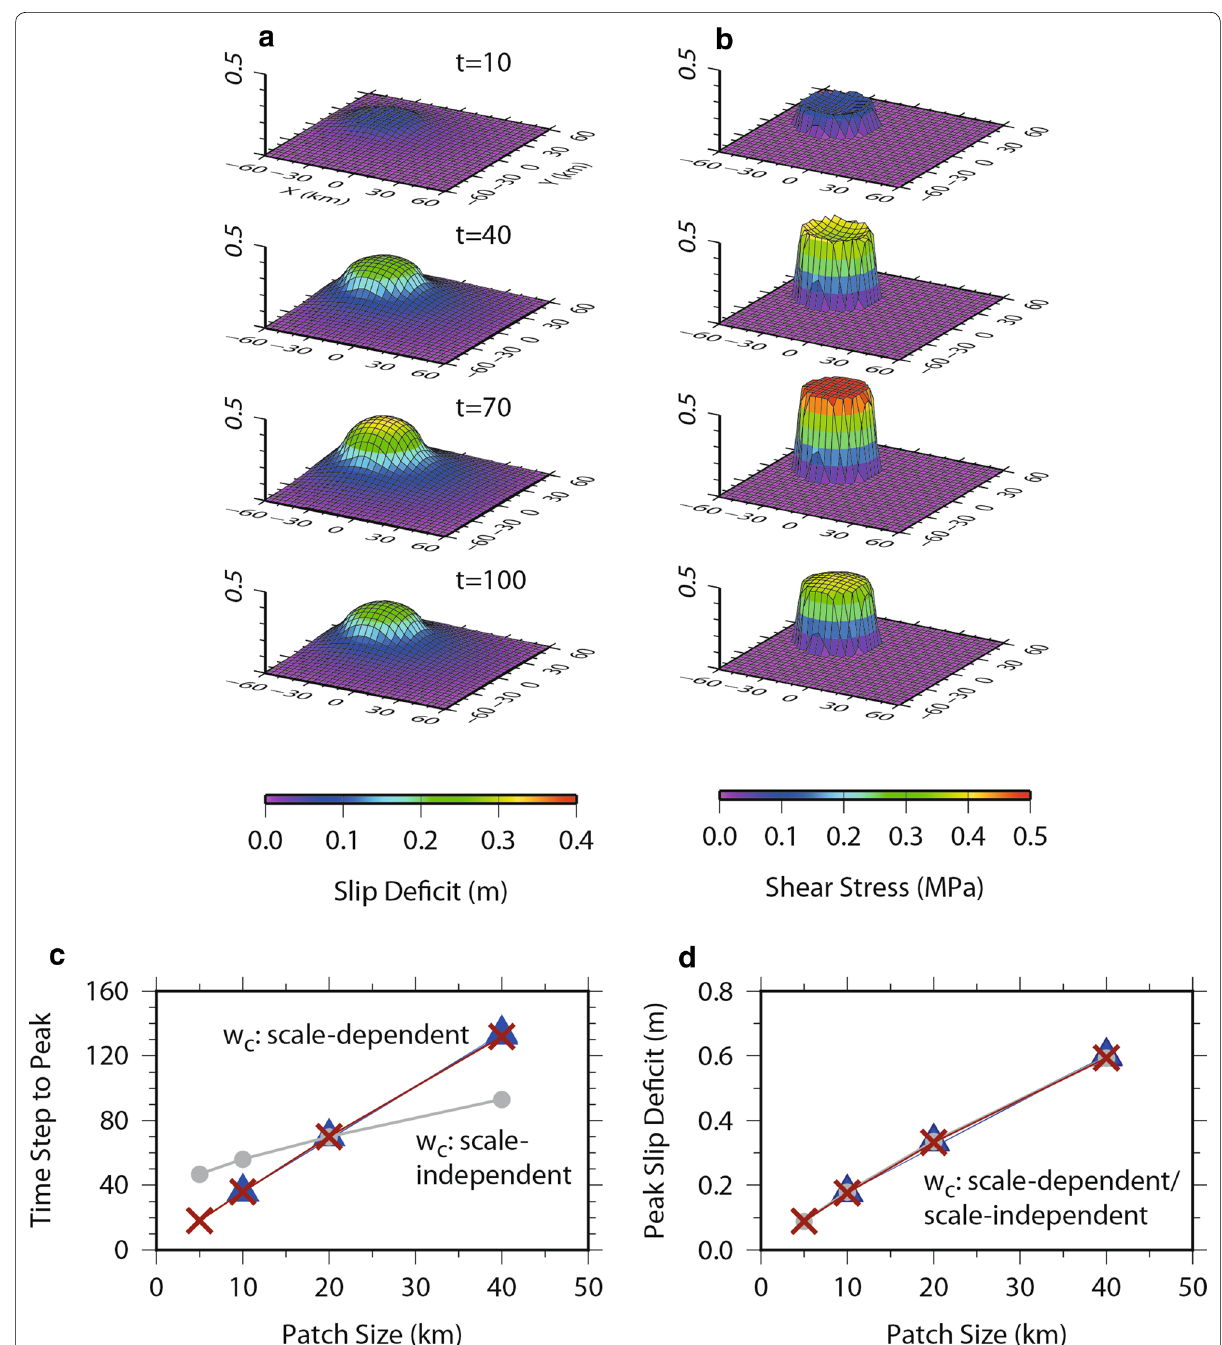
Fig. 2 Snapshot of the quasi-static evolution of fault slip for a single patch of R = 20 km , w c = 0.4m , w 0 = 0m , and γ = 2 , in terms of a slip deficit and b shear stress. At approximately time step 70, the peak in slip deficit is observed. c Time step necessary to reach the peak in slip deficit, with variable R and γ (Table 2). All the cases ( γ 1, 1.1, 1.5, and 2) are superposed, represented by solid large symbols ( crosses : γ = and 1.5) and lines . The pale gray small circles and lines represent the cases where w c is not scaled with patch size R ( w c = 0.4m fixed). d Peak slip deficit at the center of the patch for each case. Markers are the same as in the previous